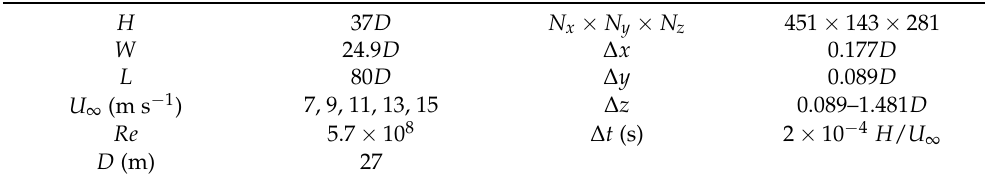
Table 1. Geometrical and wind characteristics of the SWiFT site model simulations used for the training and validation of the CNN. U ∞ is the free-flow velocity. Re is Reynolds number. D is the diameter of the turbine rotor (=27 m). N x , N y , and N z are the number of computational grid nodes in windwise, spanwise, and vertical directions, respectively. ∆ x , ∆ y , and ∆ z are the special resolution in windwise, spanwise, and vertical directions, respectively.